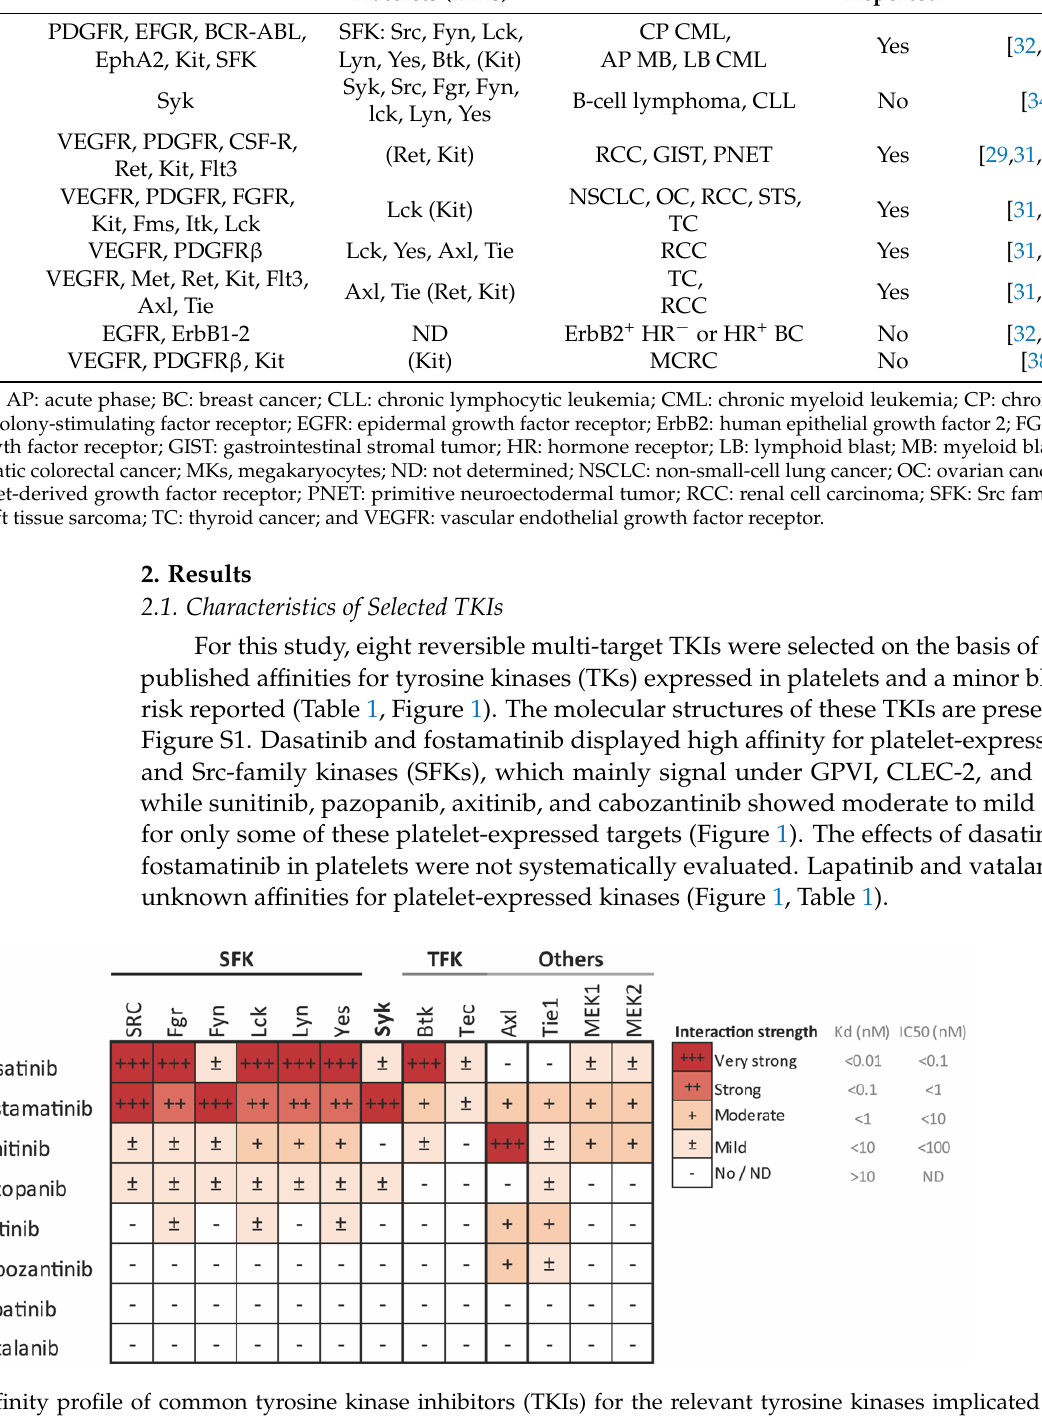
Figure 1. Affinity profile of common tyrosine kinase inhibitors (TKIs) for the relevant tyrosine kinases implicated in platelet activation, presented as a heatmap of the affinity-based dissociation constants (Kd) [39–41] or IC 50 values [42] of the indicated TKIs. Values are from binding experiments with the indicated purified kinases, including Src family kinases (SFK), Syk, Tec family kinases (TFK), focal adhesion kinases (FAK), and MEK. Color coding shows the highest affinity (lowest Kd or IC 50 ) in deep red and the lowest affinity (highest Kd or IC 50 ) in white. Data are based in